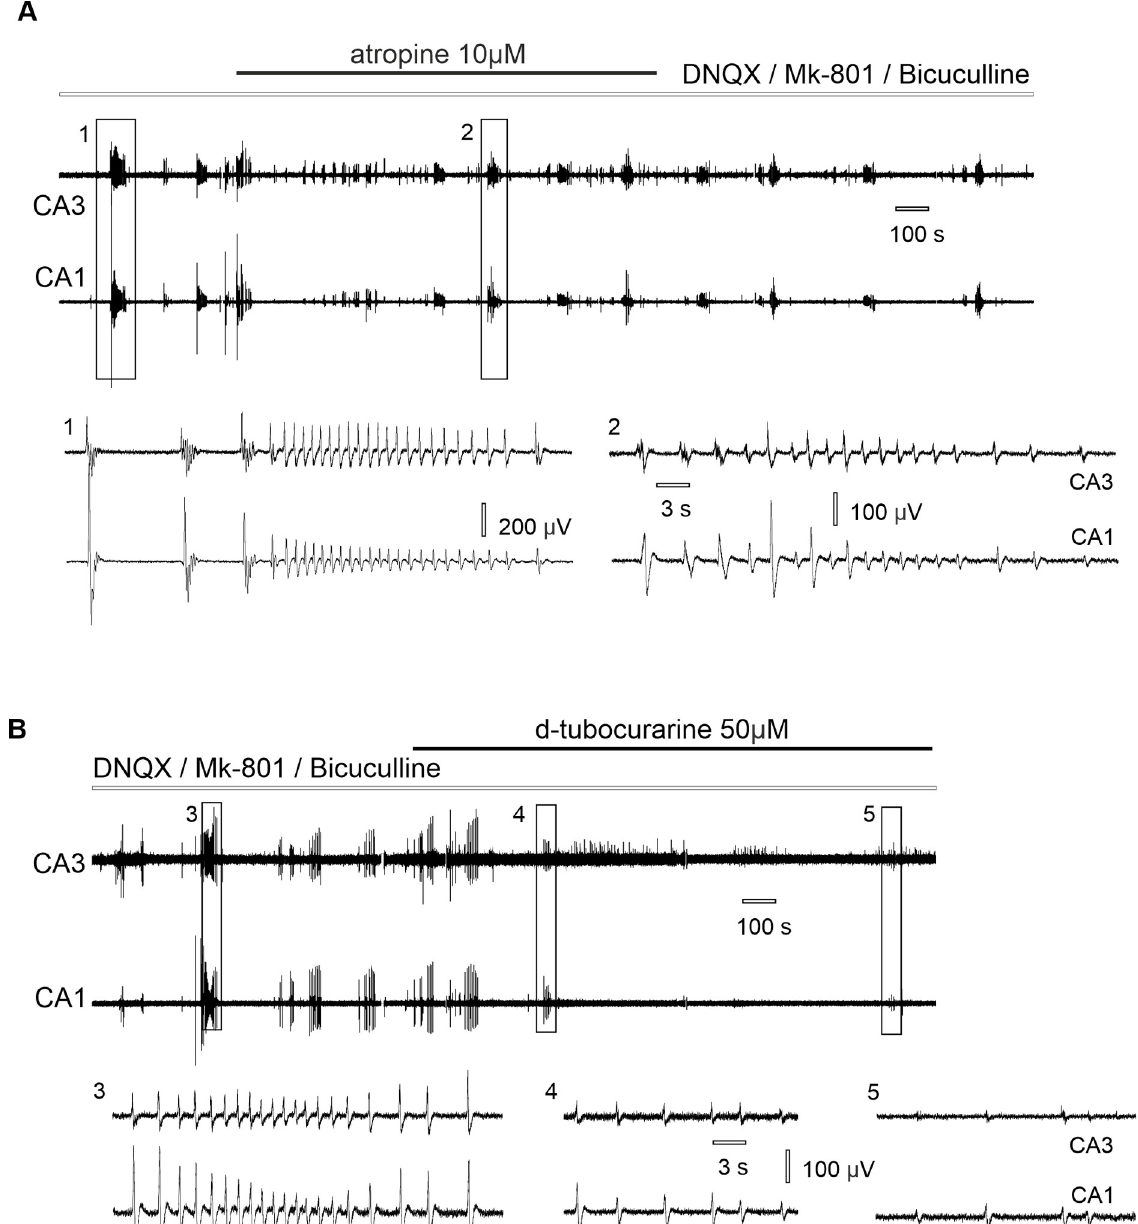
Fig 4. Effect of cholinergic antagonists on CA3-CA1 synchronous epileptiform discharges induced in synaptic blockers aCSF. (A) Application of atropine does not block CA3-CA1 synchronous discharges: (1) burst of discharges in synaptic blockers aCSF, (2) synchronous epileptiform discharges appear during atropine application. (B) Application of d-tubocurarine blocks CA3-CA1 synchronous epileptiform discharges: (3) burst of discharges in synaptic blockers aCSF, (4) reduction of the discharges after tubocurarine application, (5) epileptiform discharges decrease under tubocurarine